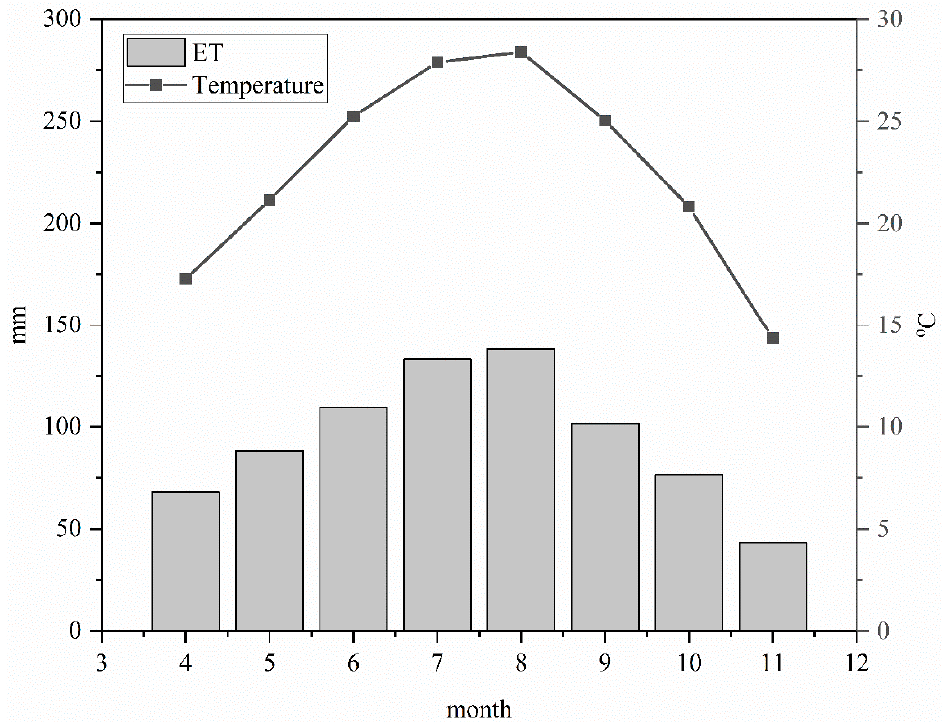
Figure 5. Average monthly temperature and potential evapotranspiration from April to November between 2015 and